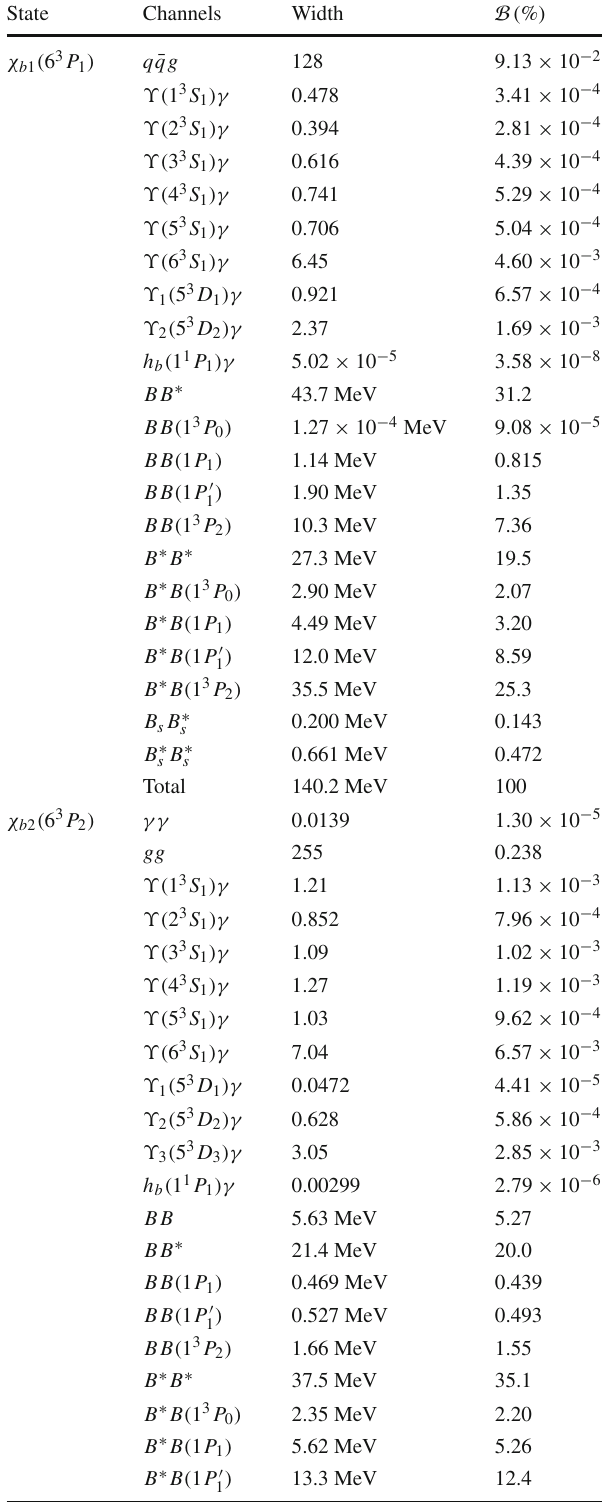
Table 26 Partial widths and branching ratios of OZI-allowed strong decay, annihilation decay, and radiative transition and the total widths for 6 3 P 1 and 6 3 P 2 bottomonium states. The width results are in units of